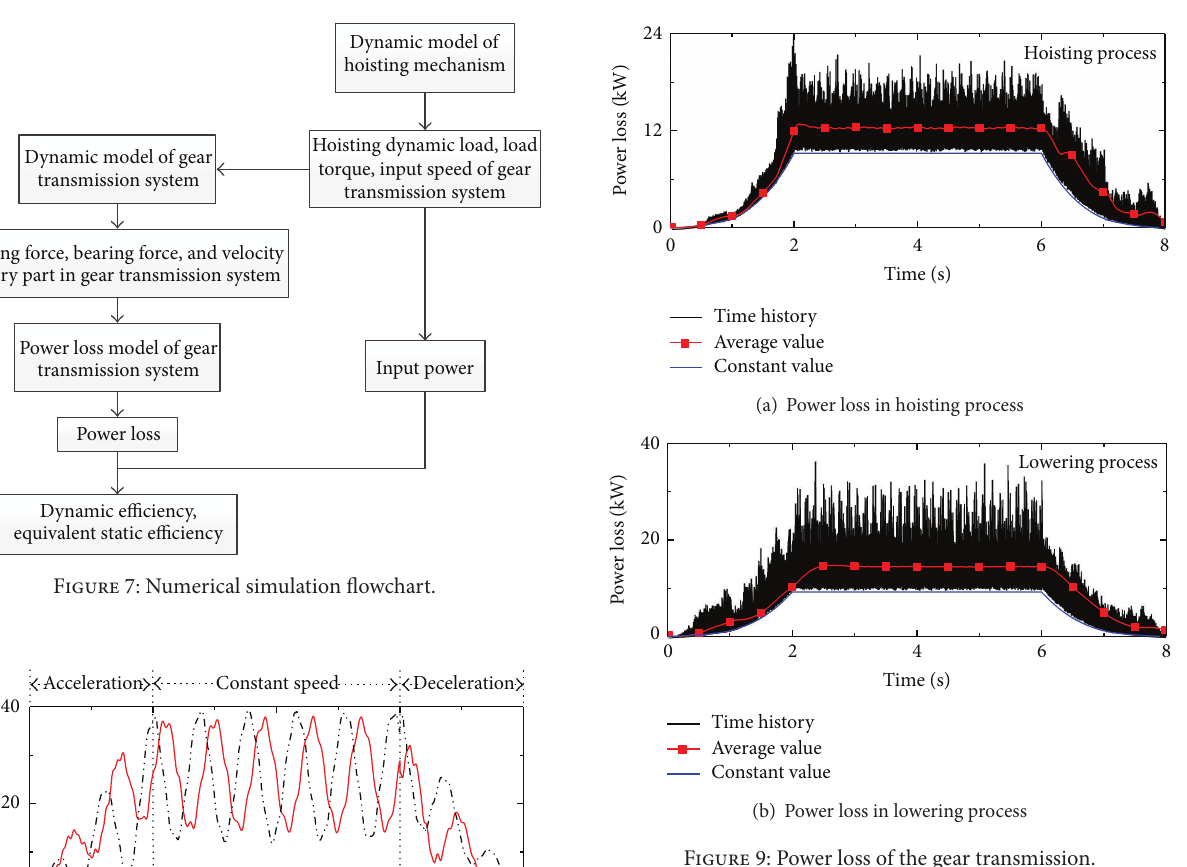
Figure 9: Power loss of the gear